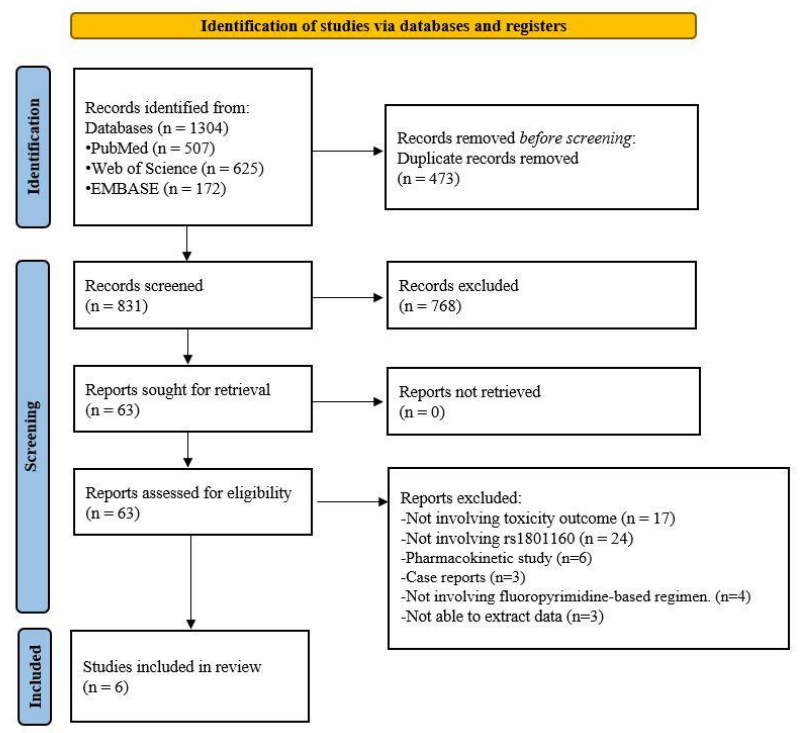
Figure 1. Flow diagram of the study selection process.